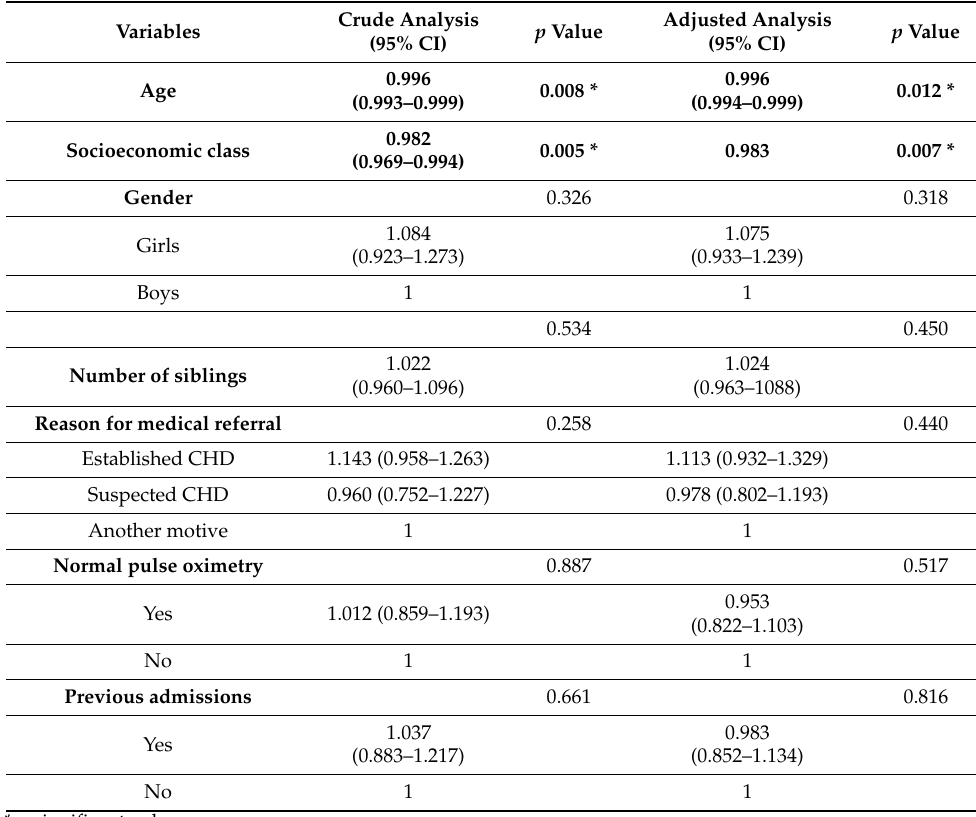
Table 4. Crude and adjusted analysis of risk factors related to nonverbal intelligence deficits.